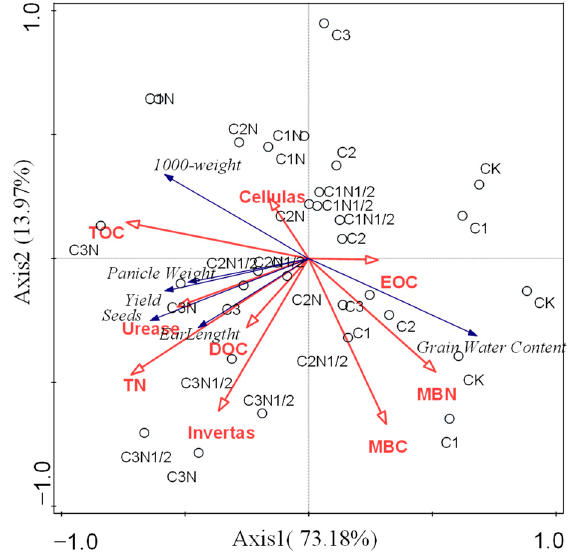
Figure 4. Redundancy analysis (RDA) between soil carbon and nitrogen content, their active fractions, enzyme activity, and wheat yield indicators. The blue arrows represent soil environmental factors and the red arrows represent agronomic traits of the wheat.